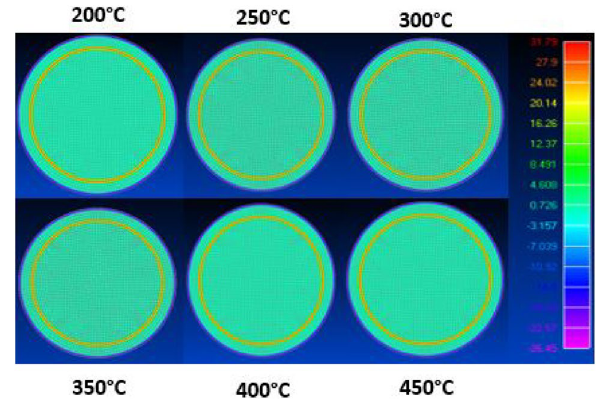
Fig. 6 Heat flux across the well at different steady-state thermal regimes (for the view of figures with labels and coordinates, a reader is advised to see Online Appendix A1)